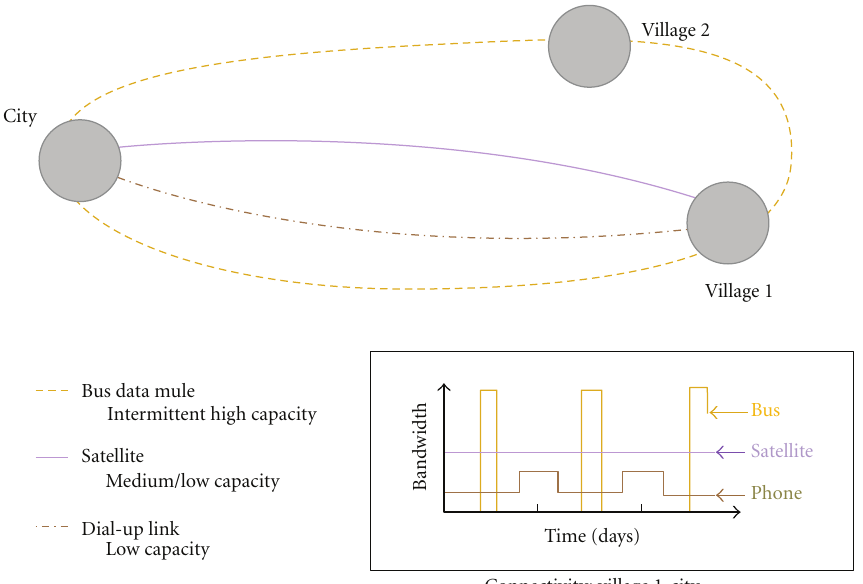
Figure 2: Comparison of common bandwidth versus time data exchange in intermittent island and medium/low capacity but connected island